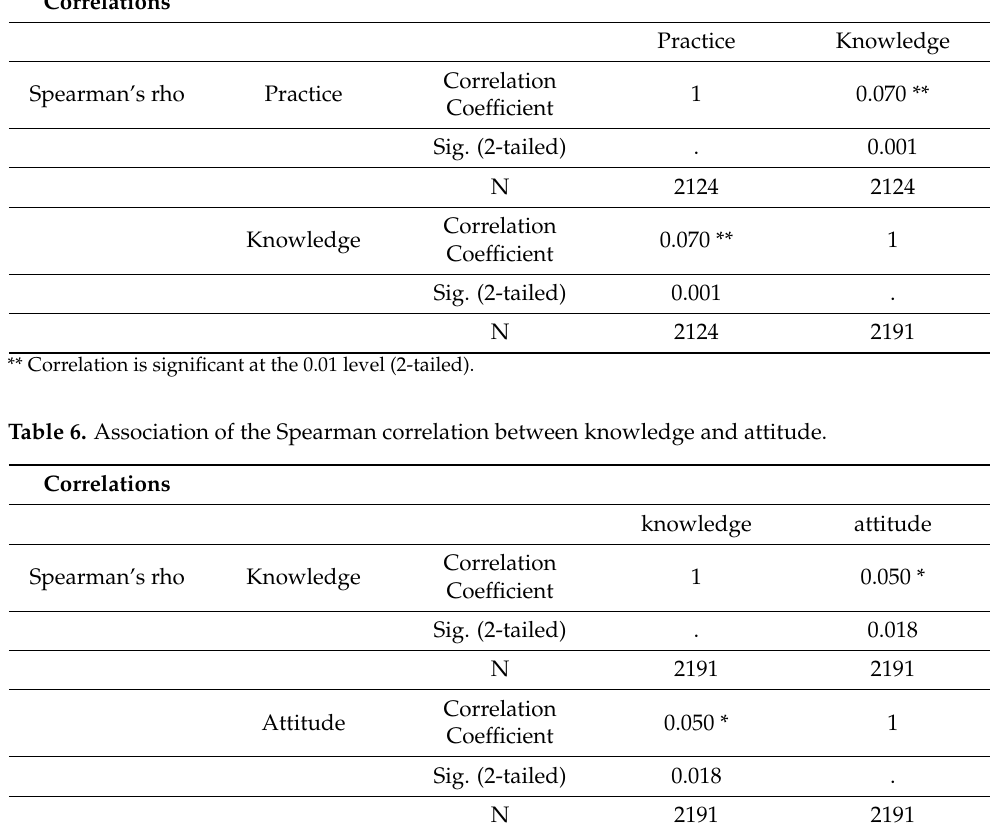
Table 5. Association of the Spearman correlation between knowledge and practice. Correlations